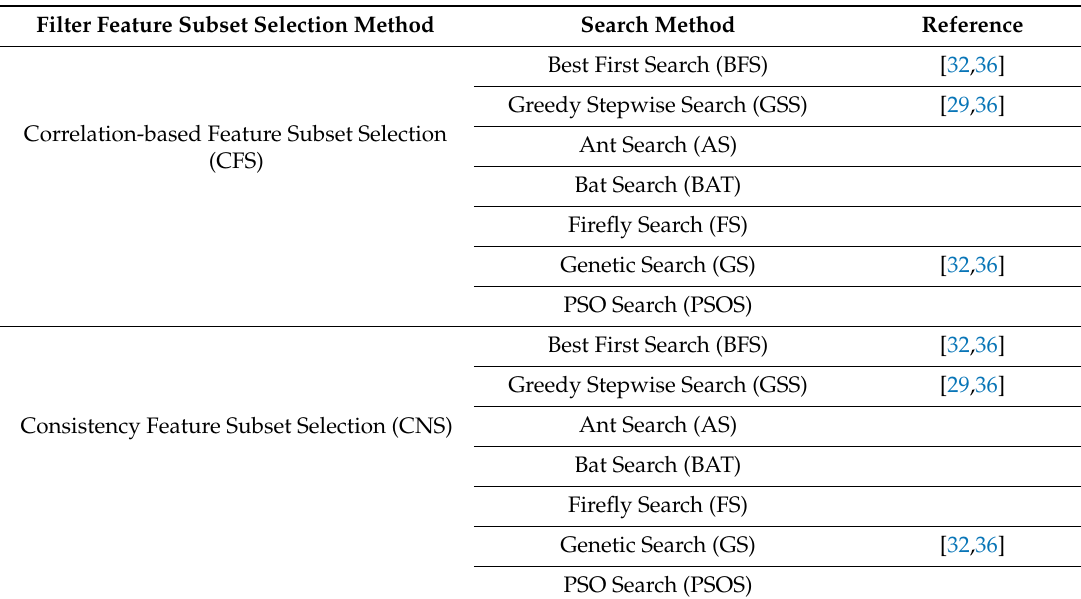
Table 2. List of Filter Feature Subset Selection (FSS) Methods.